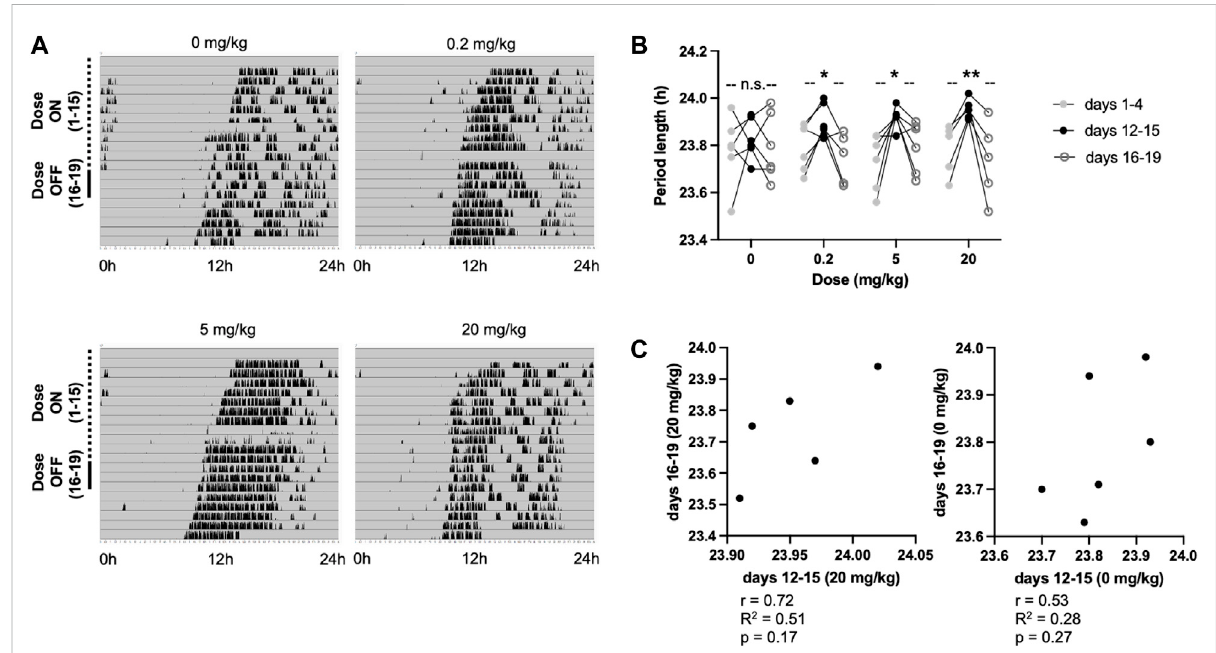
FIGURE 4 Effect of CT1500 on entrainment in free-running mice. (A) C57Bl6/J ( n = 5/6 per group) male mice housed constant dark (grey) and wheel runningactivityindicatedinblack.Theanimalsreceivedasingleoraldoseoftheindicatedtreatmentat10ameverydaymarkedinthedottedline,and no treatment during the days marked with the solid line. Represented actograms shown (B) Period length across the indicated days analysed with One way ANOVA which indicated a signi fi cant effect of drug (n too small to calculate normality). Two-stage linear step-up procedure of Benjamini,KriegerandYekutielimultiplecomparisons*( p < 0.05)or**( p < 0.01)indicateasigni fi cantincreaseinperiodondays12 – 15(ontreatment) relative to days 16 – 19 (off treatment) (C) Correlation of period length on drug (days 12 – 15) versus after withdrawal (days 16 – 19) indicated for two doses, showing no signi fi cant correlation (Pearson ’ s r, R2 and p -value